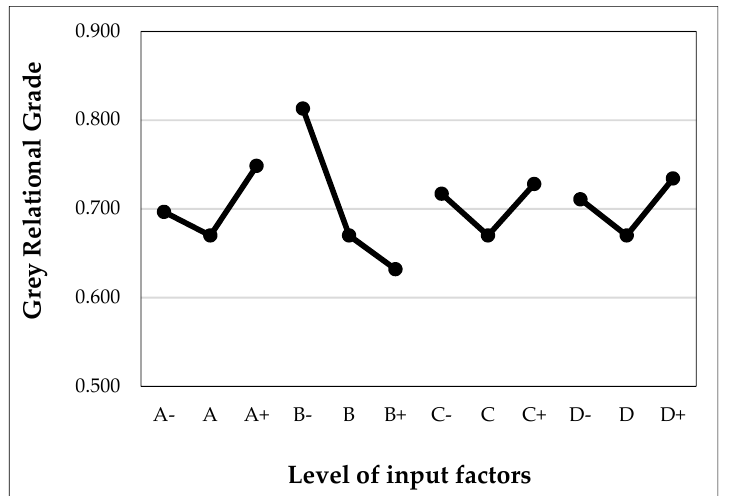
Figure 14. Effect of turning factors on the multi ‐ characteristic .